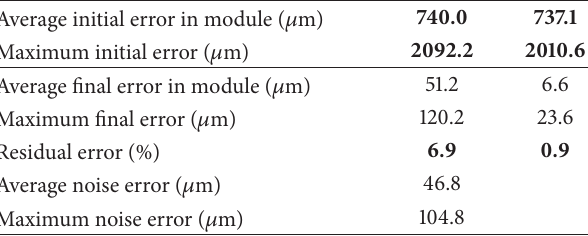
Table 10: Linear axis characterization with and without measure- ment